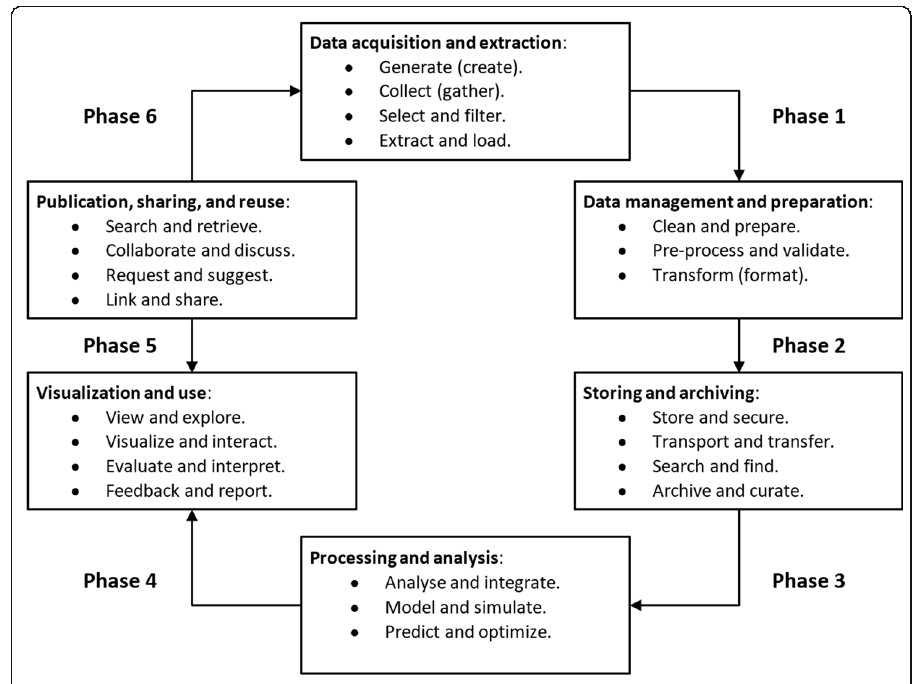
Fig. 6 The BOLED analytics lifecycle phases. Source: Ln ě ni č ka and Komárková